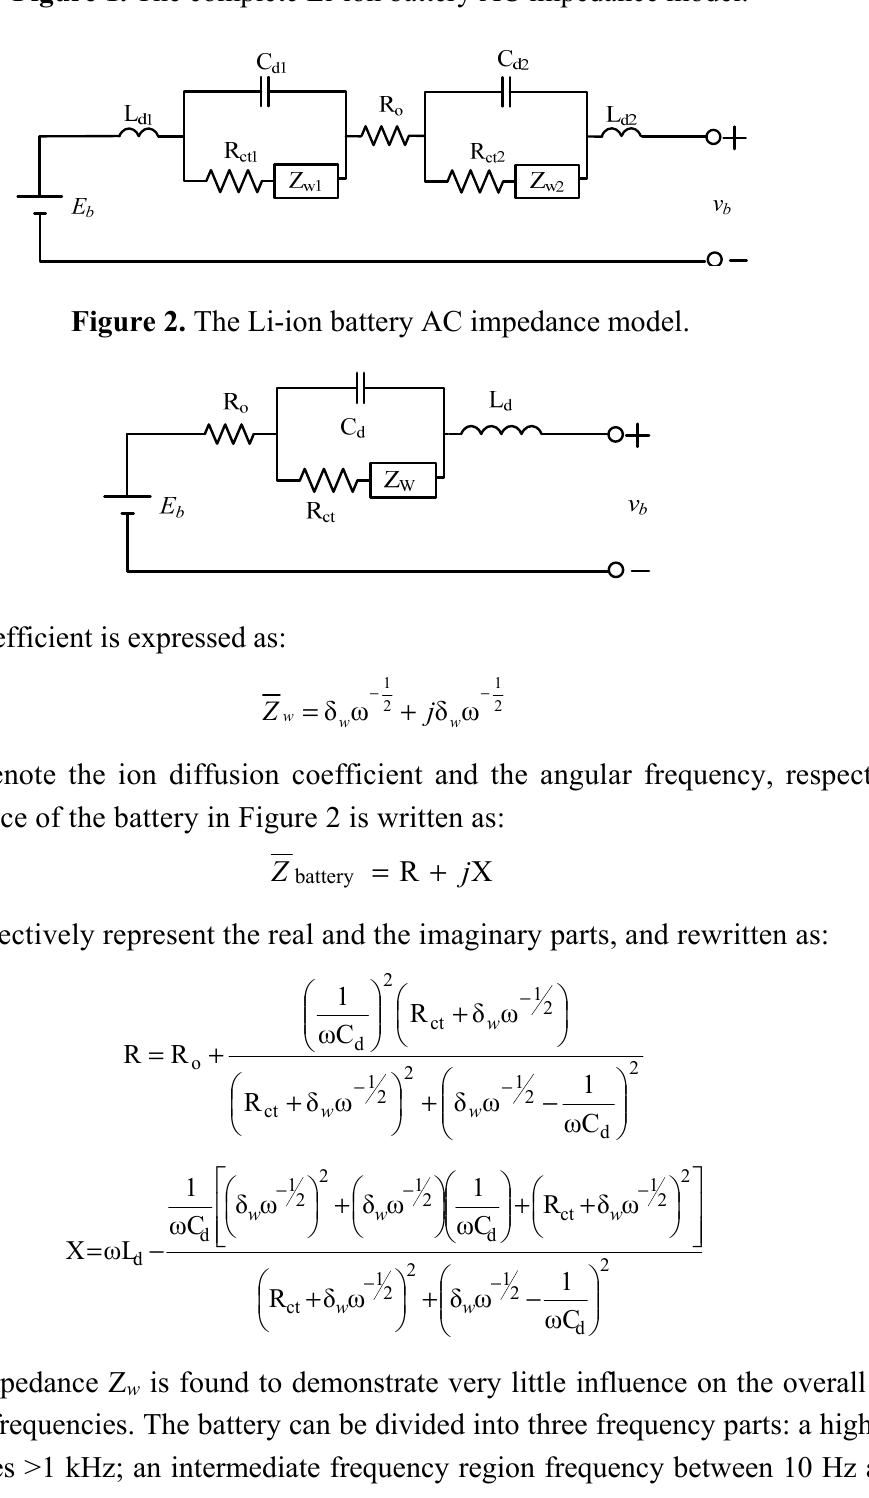
Figure 1. The complete Li-ion battery AC impedance model.